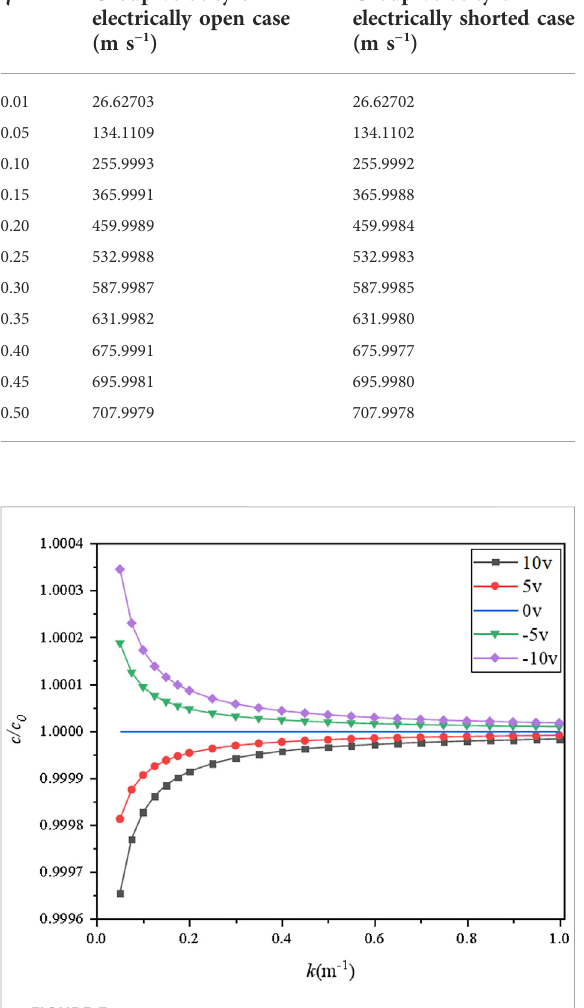
FIGURE 3 Effect of external electric voltage on phase velocity of localized bending waves.